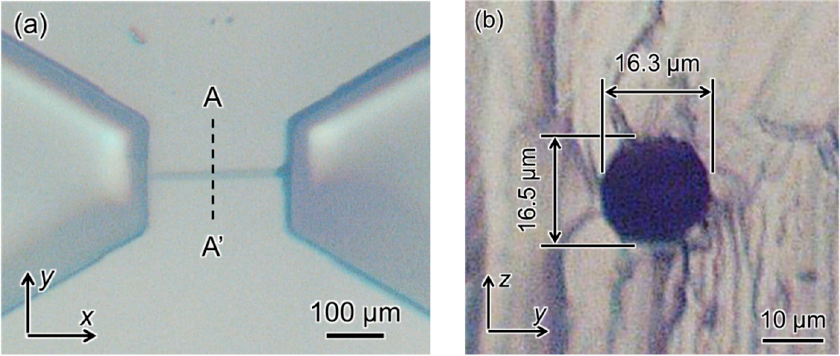
Figure 12. ( a ) Microscopic image of a PDMS microchannel mold fabricated using FMEx; ( b ) Cross-section of the microchannel at section A-A'.